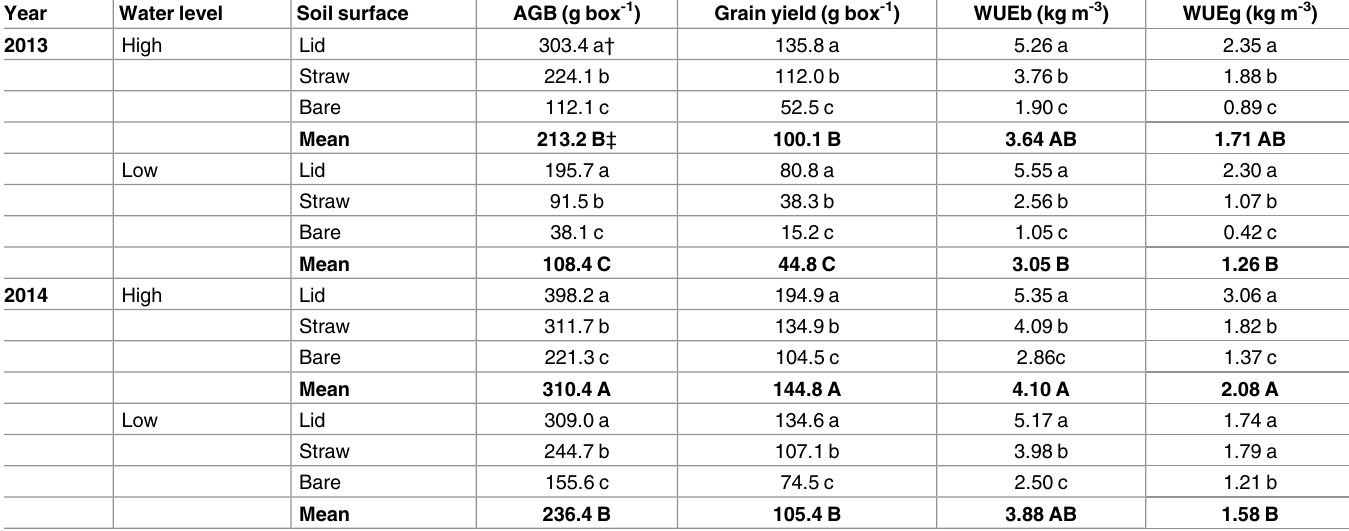
Table 3. Means of aboveground biomass (AGB), grain yield, biomass water use efficiency (WUEb), and grain water use efficiency (WUEg) of sor- ghum grown in 2013 and 2014 at two water levels and three